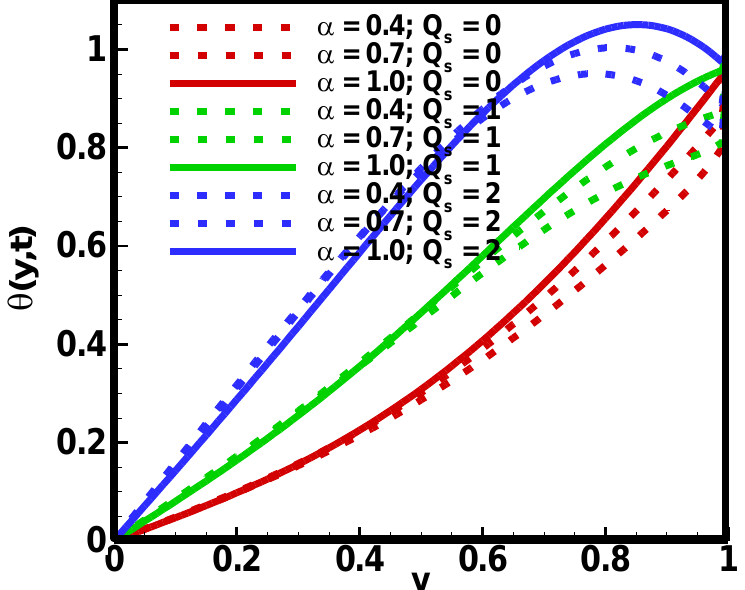
Figure 12. Influence of absorption/source of heat parameter Q s on θ ( y , t ) ,when (cid:101) = 0.5, Ha = 5, Pr = 21, Q s = 5, Nr = 3.5, φ = 0.1.